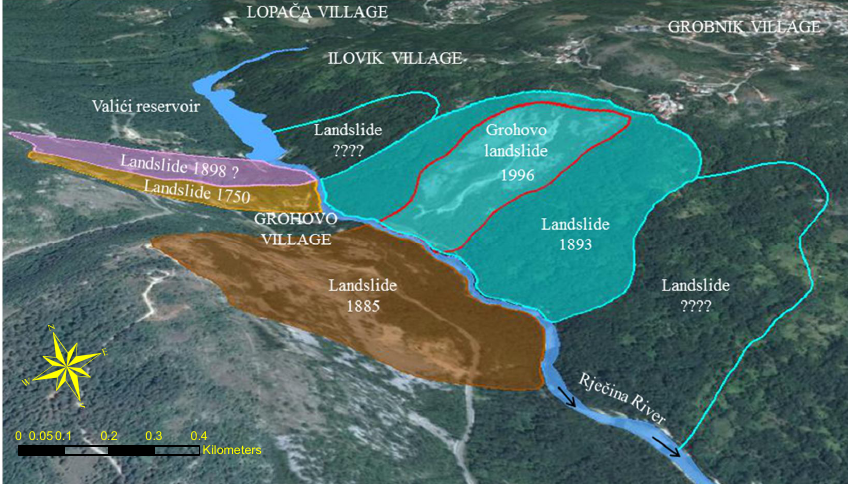
Figure 1. Map of landslides on the wider area around the Grohovo